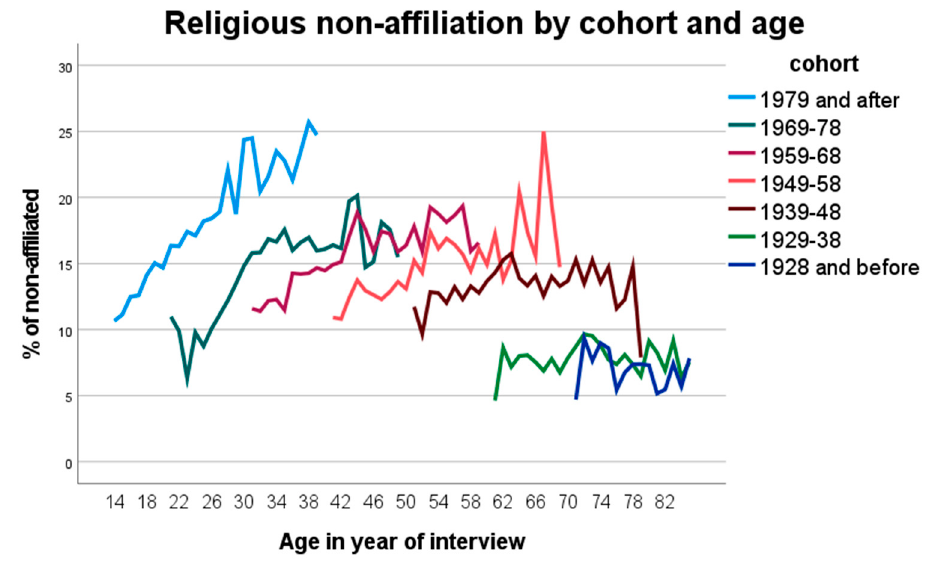
Figure 1. Proportion of religious non-affiliation by cohort and age.